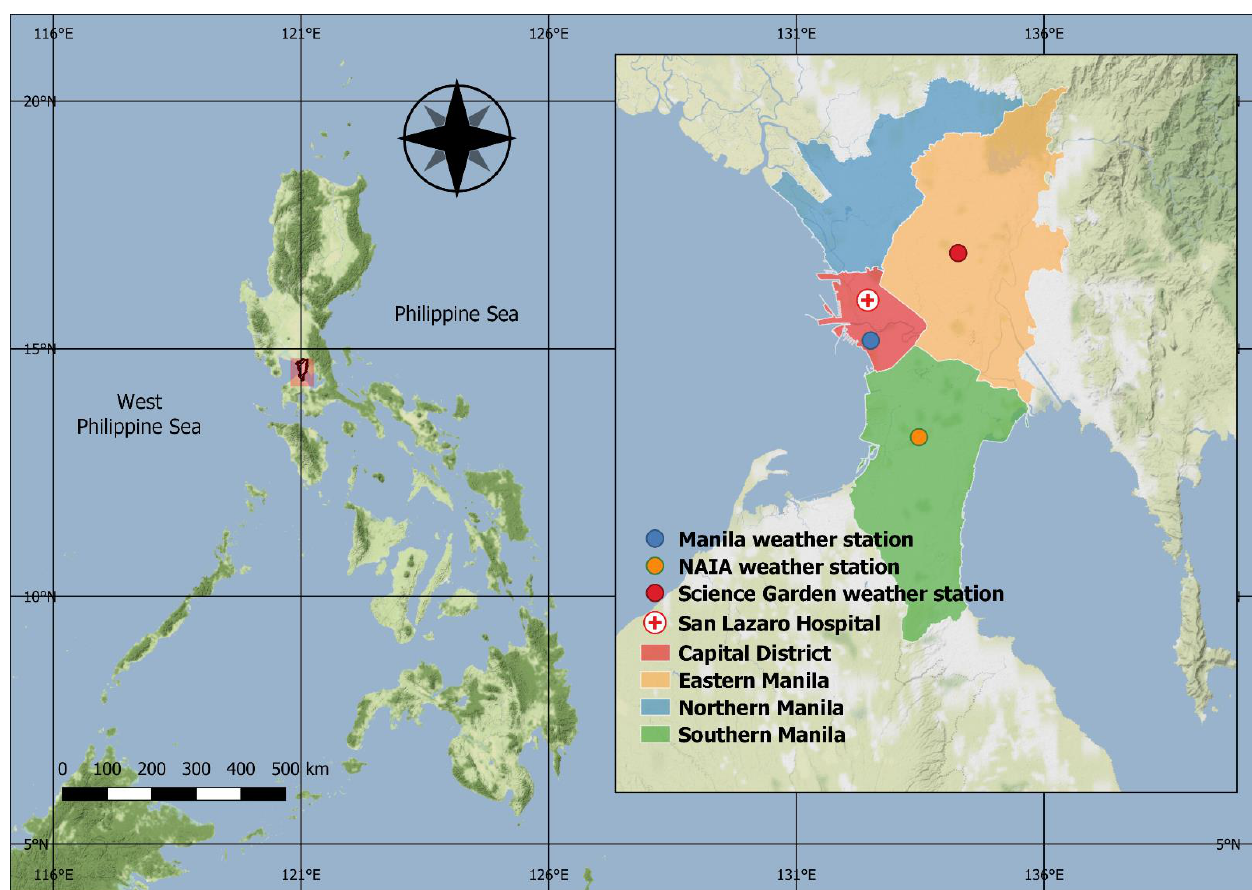
Figure 1. National Capital Region districts, weather stations, and San Lazaro Hospital. Map is generated using QGIS 3.16 with stamen.